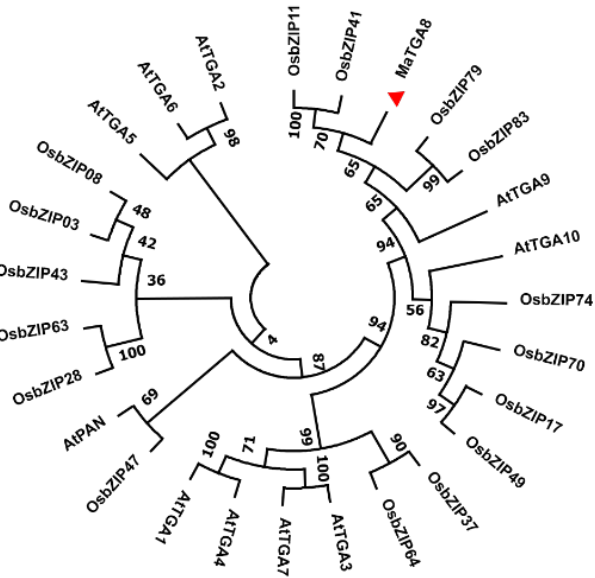
Figure 1. Phylogenetic analysis of MaTGA8 and the TGAs family of Aarabidopsis and Oryza sativa. The protein structure of MaTGA8 was analyzed. ORF of MaTGA8 contained 504 amino acids. Further analysis through protein multiple sequence alignment indicated that the MaTGA8 contained one bZIP domain and one DOG1 domain; part of the bZIP domain was composed of 14 amino acid residues as a conserved DNA binding site, and the other part was the leucine zipper region involved in the formation of dimers (Figure 2). This indicates that MaTGA8 belongs to the bZIP transcription factor family Group D subfamily.